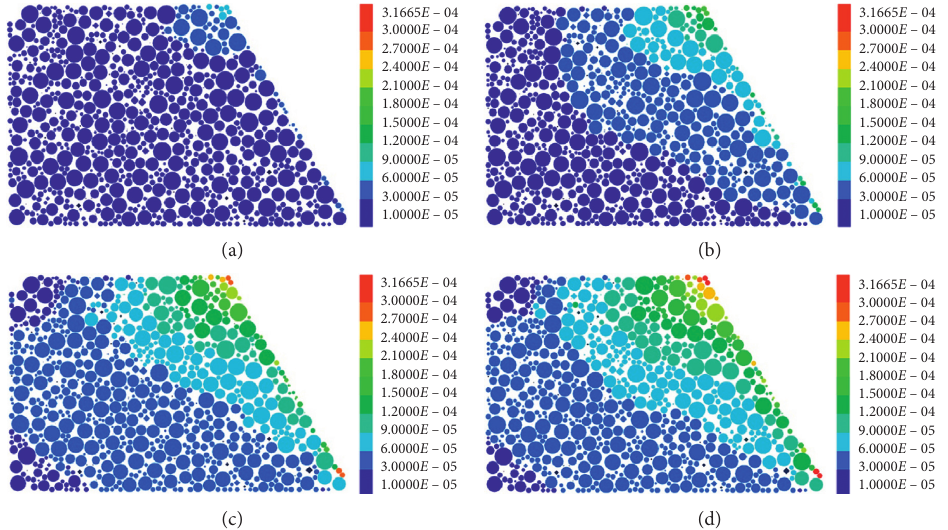
Figure 14: Displacement field of the 60 ° slope at 20% FH depth (unit: m). (a) 2, (b) 4, (c) 6, and (d) 8.